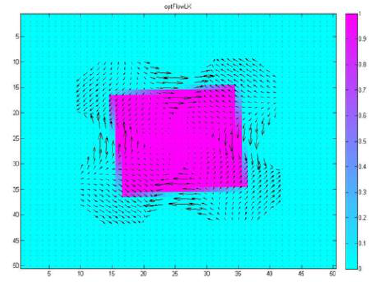
Figure 13. Results of Lucas/Kanade (Win=2, Sigma=2)